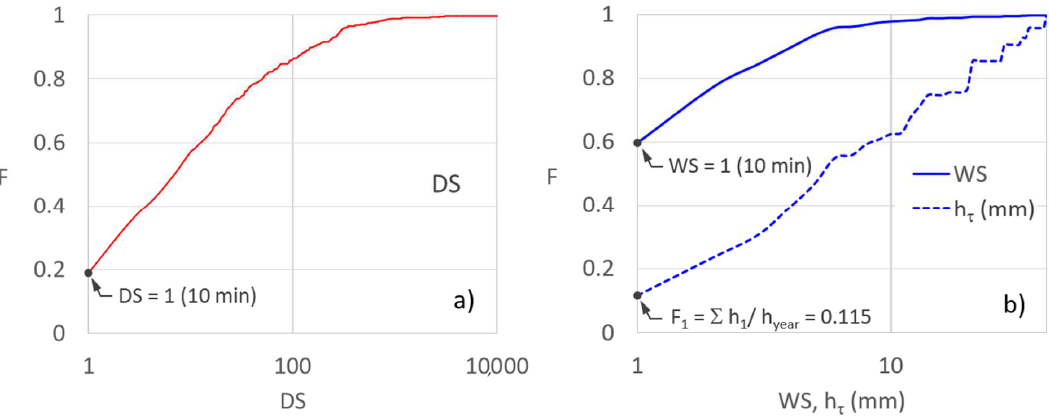
Figure 2. For the investigated year (2009), distributions of frequency, F , ( a ) of dry spells ( DS ), and ( b ) of wet spells ( WS ) and of the rainfall depth ( h τ ) corresponding to WS